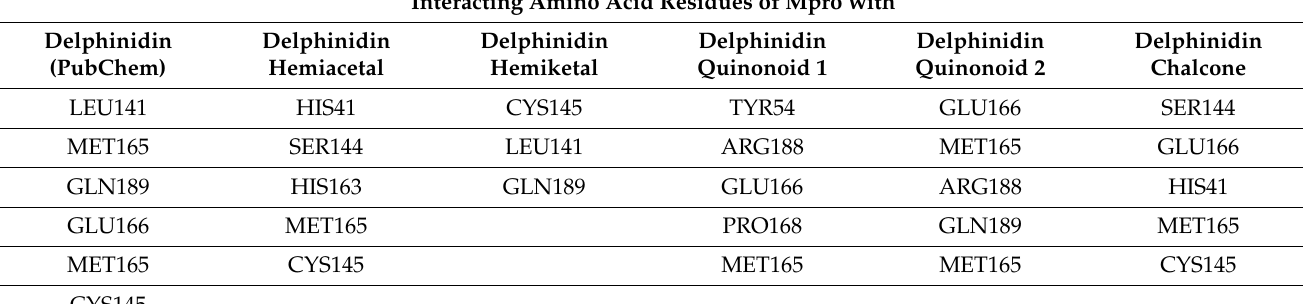
Table 5. Non-bonded interactions of delphinidin and several of its pH-based structural forms with the 3C-like protease of SARS-CoV-2 (PDB 6LU7) amino acid residues. Interacting Amino Acid Residues of Mpro